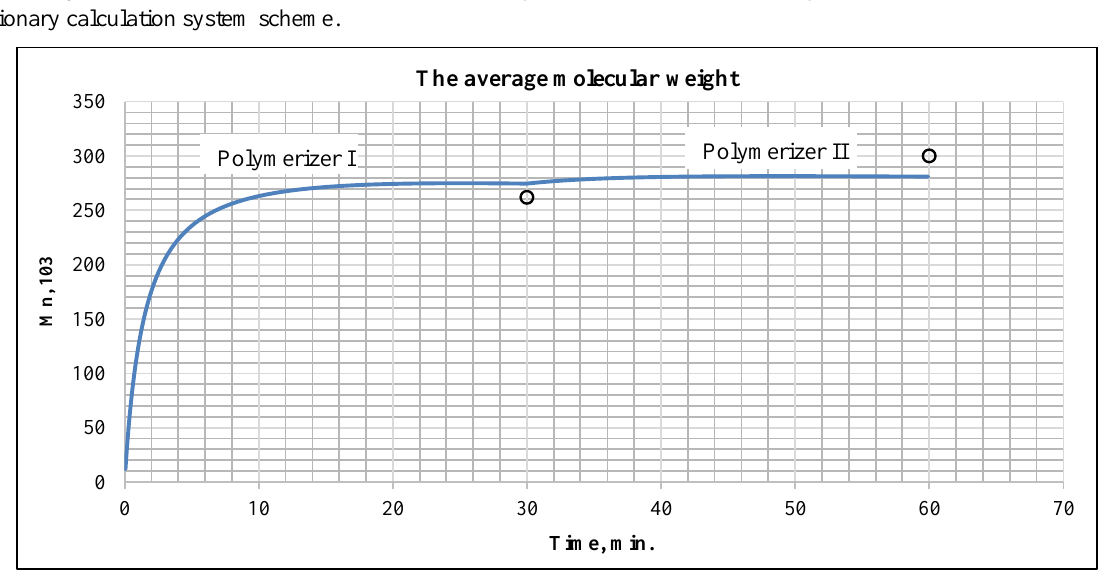
Figure 5. The dependence of the calculated average molecular weight on time for polyisoprene on the catalytic system 𝑻𝒊𝑪𝒍 𝟒 -TIBA-Pip-DFO (line denotes the results of calculations, dots show the results of a laboratory experiment).